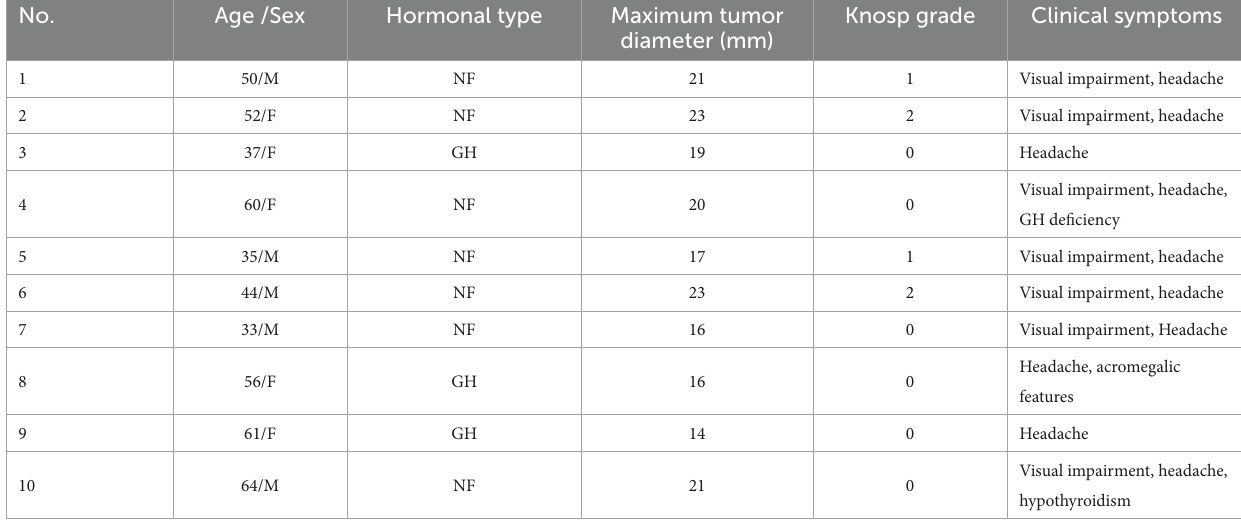
TABLE 1 Preoperative characteristics of 10